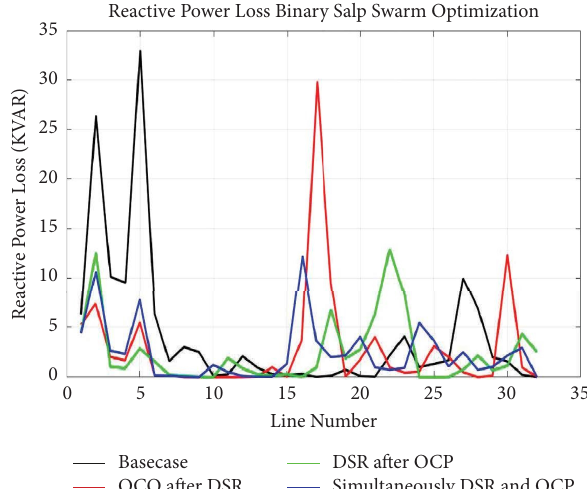
Figure 11: Reactive losses curve for 33-bus with using the BSSA algorithm for three scenarios with the base case.